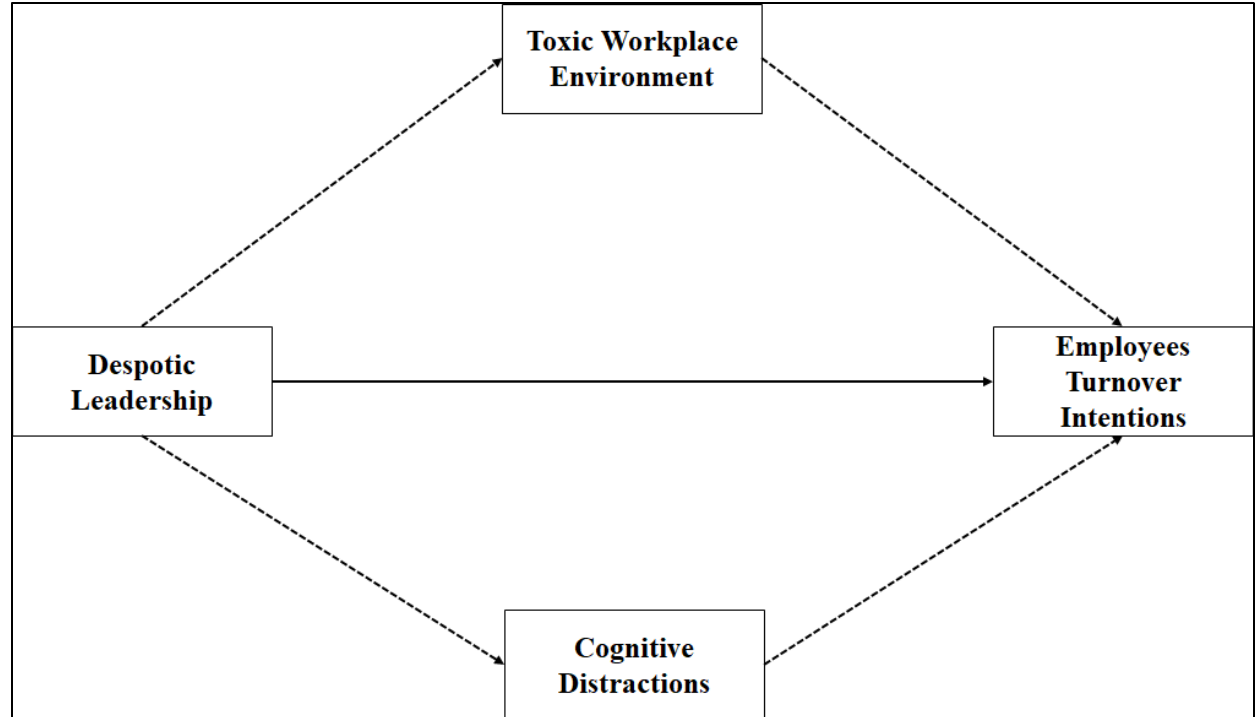
Figure 1. Research model.